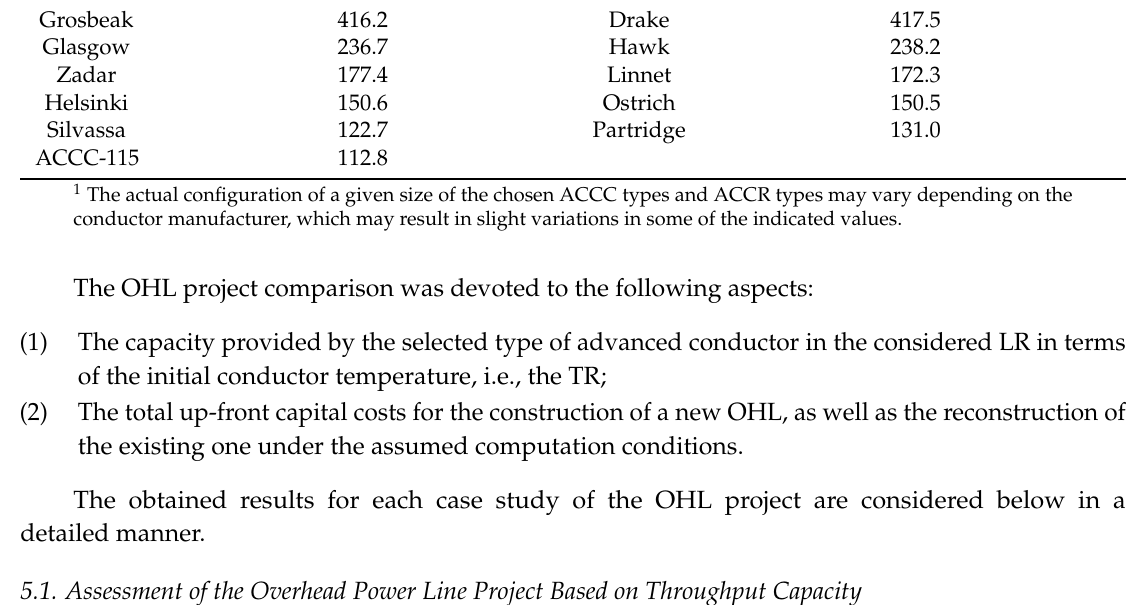
Table 8. Cross-sectional areas of examined aluminum conductor composite core (ACCC) types and aluminum conductor composite reinforced (ACCR) types for both OHLs.